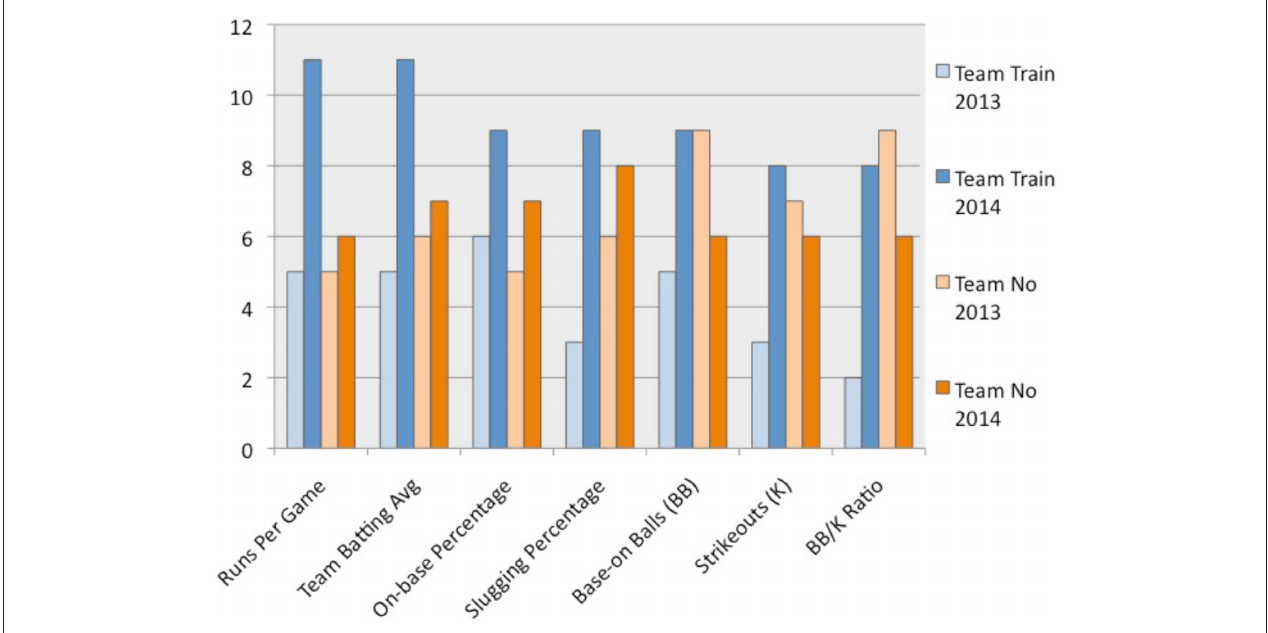
FIGURE 9 | Ranking of Training and No Training Teams in Conference(11 = best; 1 = worst).